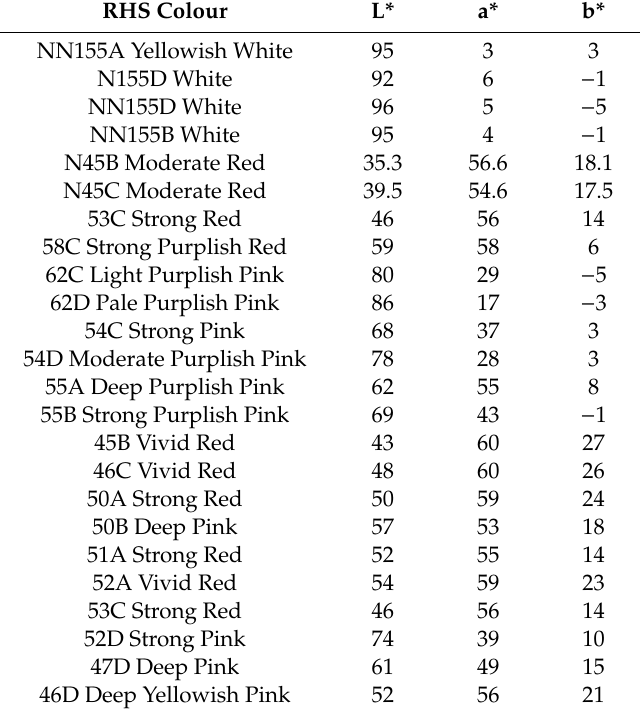
Table 3. The Royal Horticultural Society (RHS) Colour Chart [10] identification and corresponding color measurements [21]. RHS Colour L* a*